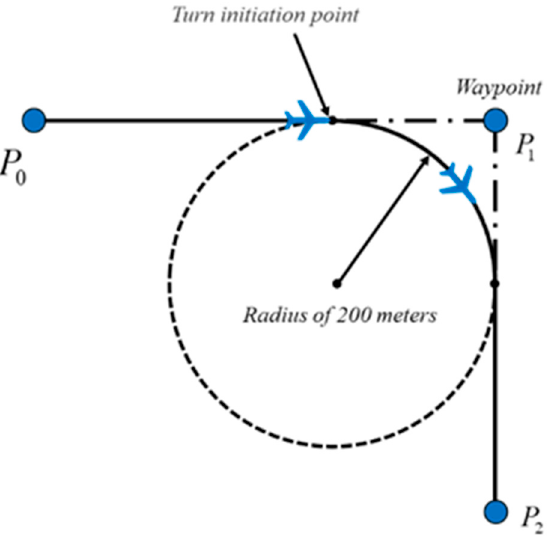
Figure 5. Relationship between flight path and waypoint in turn guidance mode.